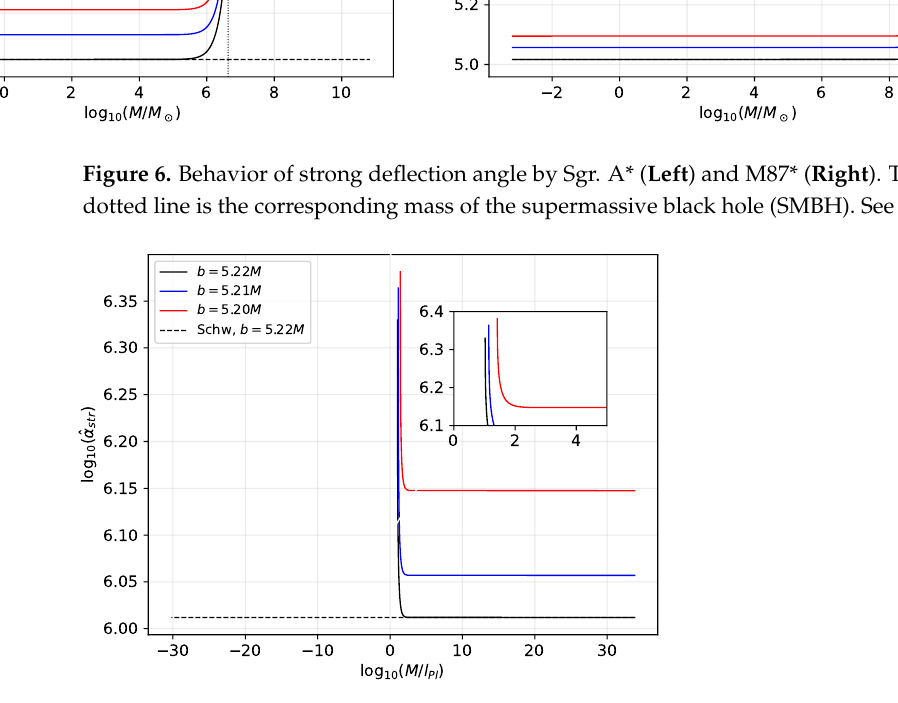
Figure 7. Strong deflection angle by quantum black